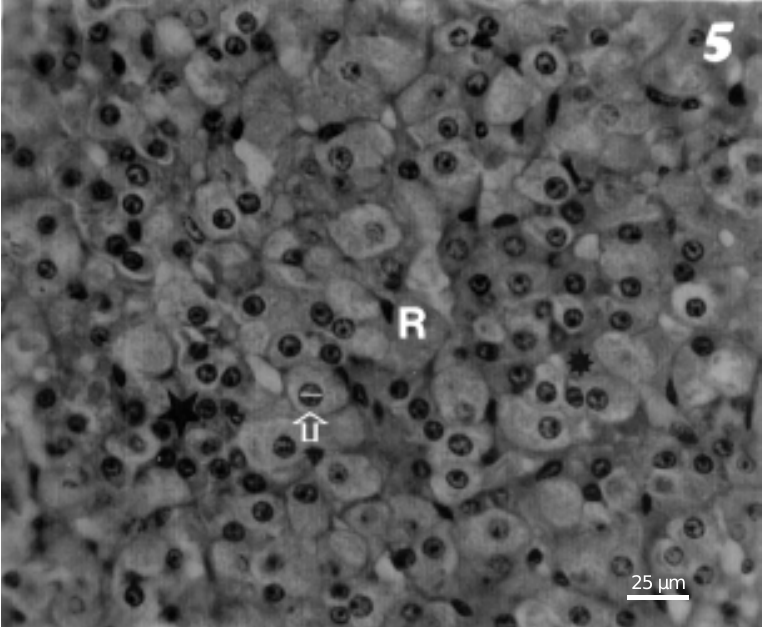
Figure 5 - Reticularis region (R) of a viscacha captured in March (summer). Most of the cells exhibit nuclei with fine chromatin and clear cytoplasms (arrow), and the nuclear diameter (line) of one of these cells is shown in the figure. The other cellular lineage presents nuclear condensation and dark cytoplasms (star). Colloidal material (*). H-E; 400X.